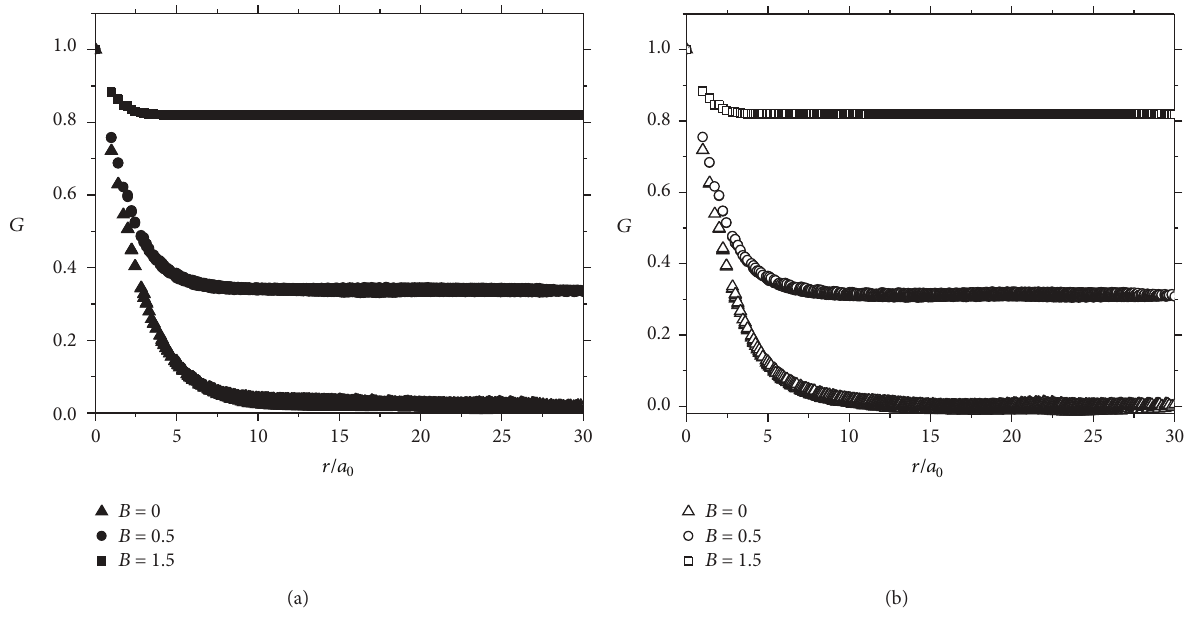
Figure 2: Variation of 𝐺(𝑟) as a function of temperature 𝑇 for (a) FQH and (b) TQH. 𝑝 = 0.1 , 𝑊 = 3 , 𝑇 = 0.5 , and 𝐿 = 70 .